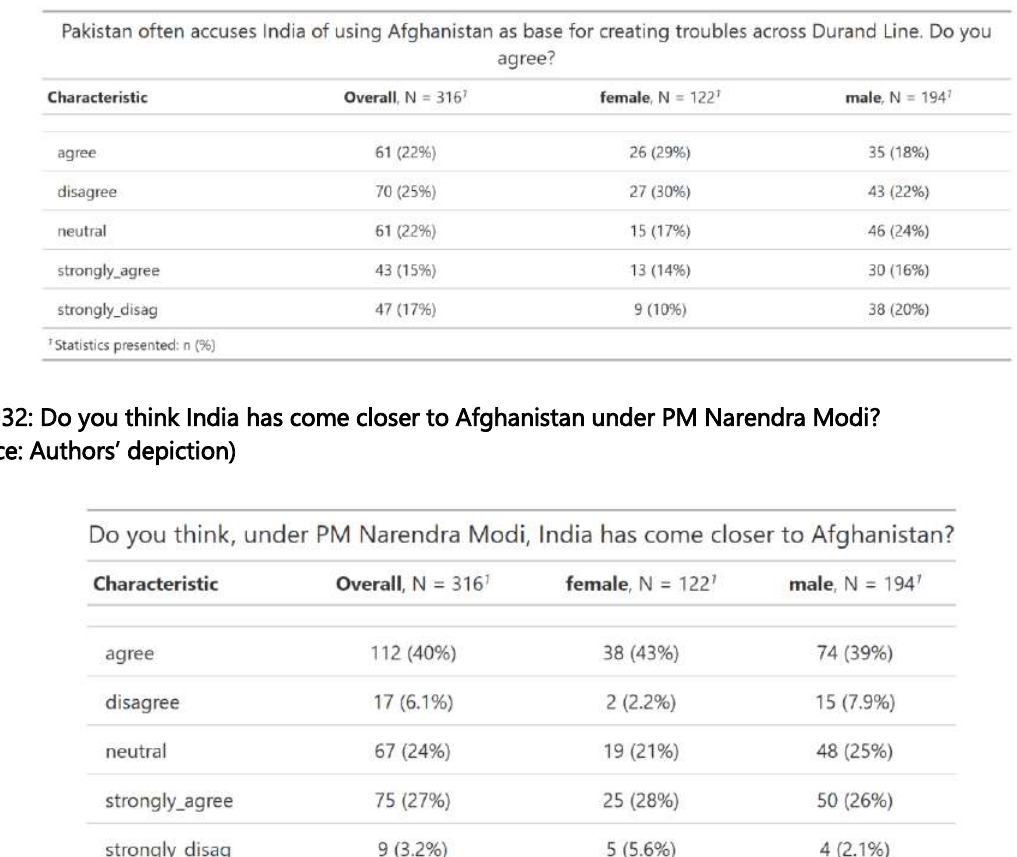
Table 31: Pakistan often accuses India of using Afghanistan as a base for creating troubles across the Durand Line. Do you agree? (Source: Authors‟ depiction )